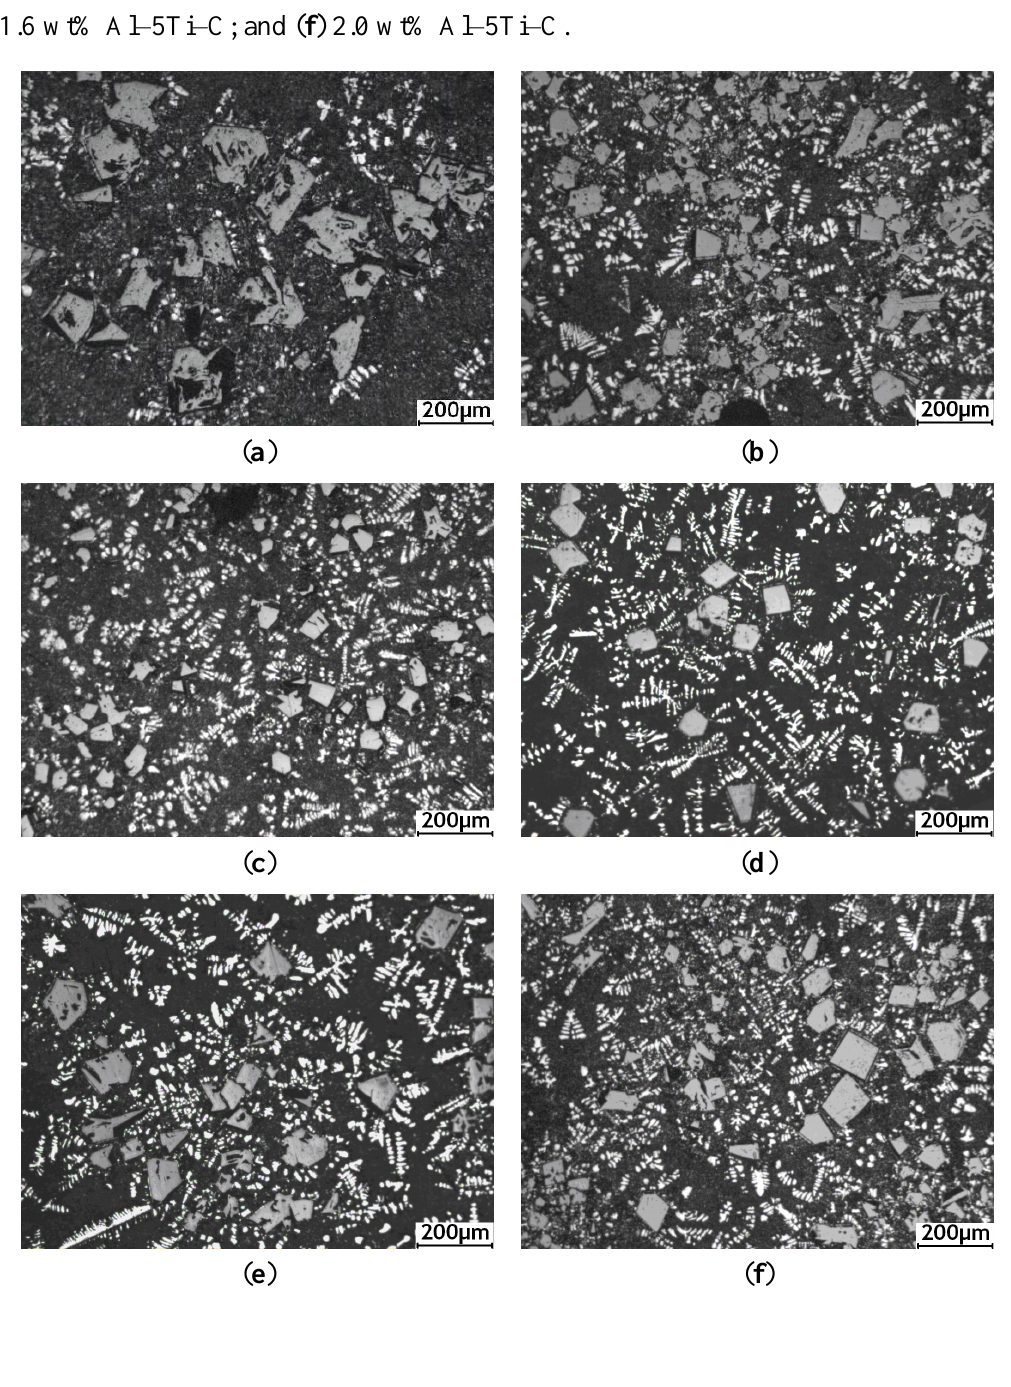
Figure 3. Optical micrographs of primary Si crystals in hypereutectic Al–20%Si